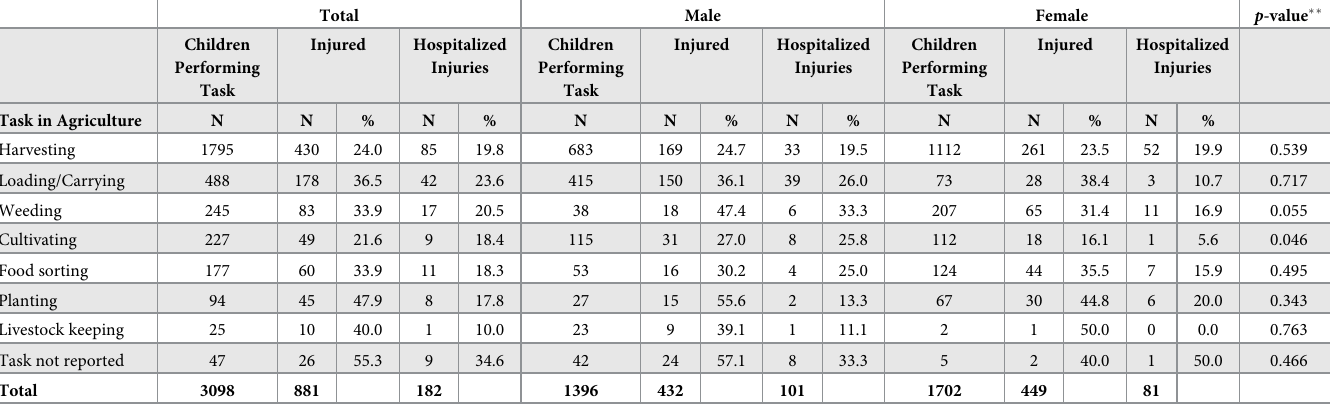
Table 5. Prevalence of injury across tasks in agriculture for male and female Syrian refugee working children in the Bekaa Valley, Lebanon, 2017 (N = 3098 �